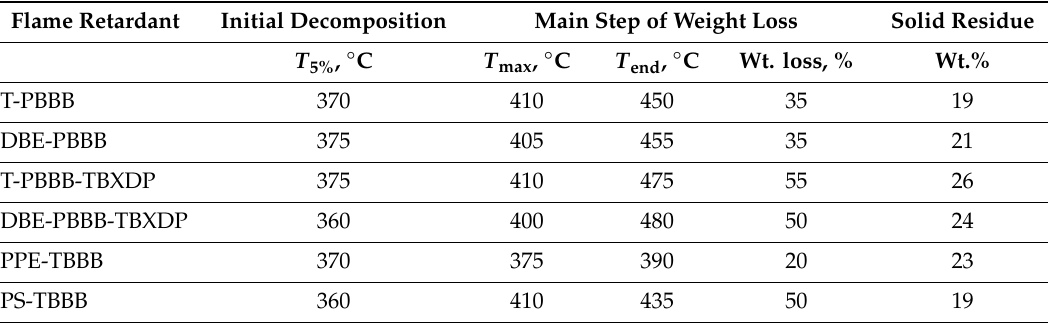
Table 2. TGA data of brominated flame